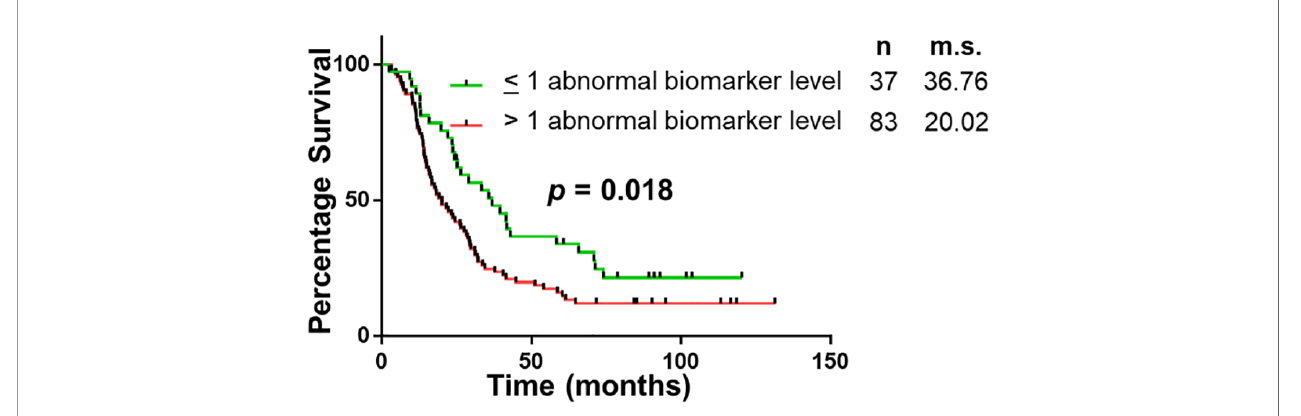
FIGURE 3 | Univariable Survival Analysis of Biomarker Panel. Kaplan Meier survival curves comparing patients with abnormal biomarker levels of one or less biomarker and patients with abnormal biomarker levels of two or more biomarkers. n, number of patients; m.s., median survival